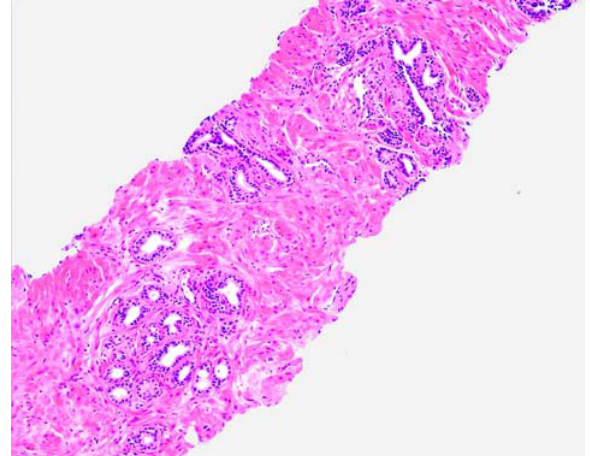
Figure 2 – Inflammatory atrophy, hyperplastic subtype (HE,